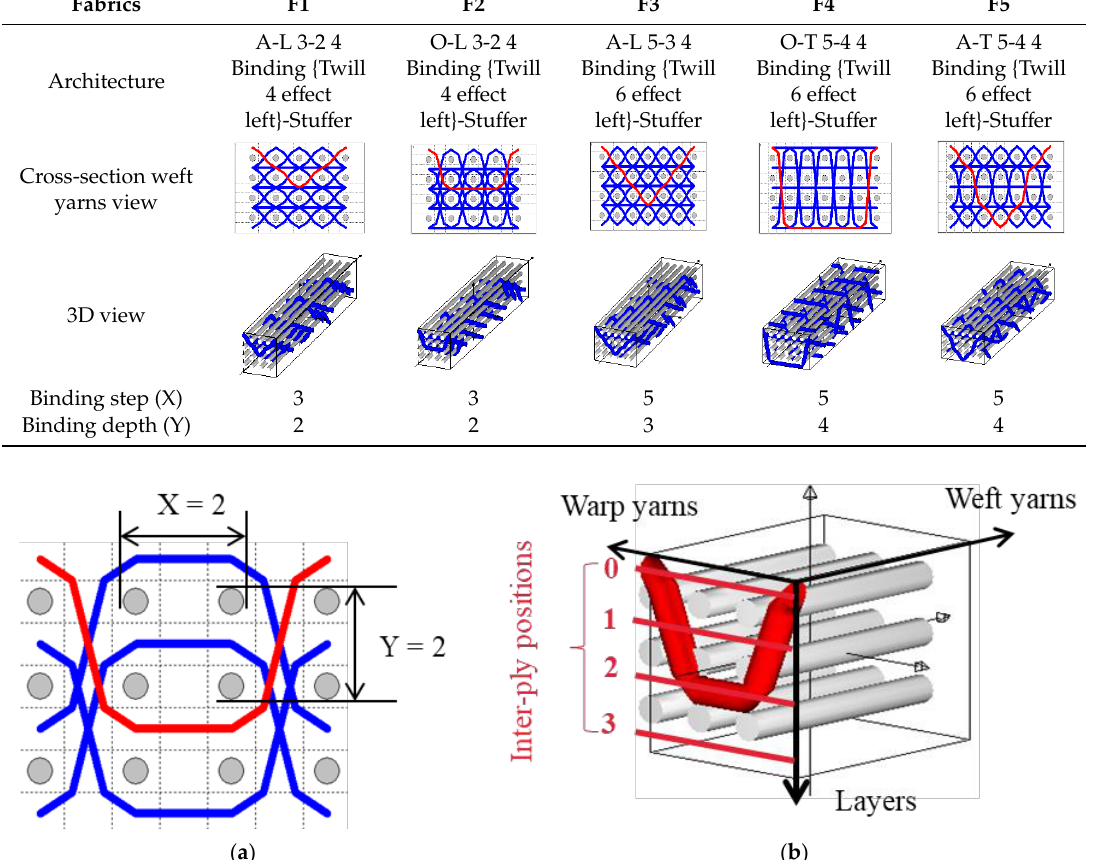
Figure 1. Representation sample of 3DWIF architectures based on the binding step and depth and the number of layers, warp binding path (X = 2) and binding depth (Y = 2): ( a ) cross-sectional weft yarns view; ( b ) 3D view.